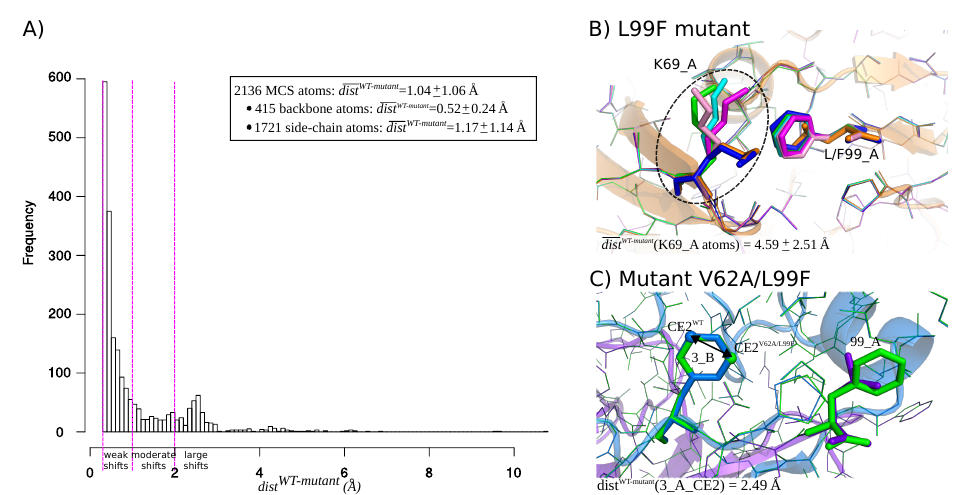
Figure 2. ( A ) Distribution of dist WT − mutant distances for MCS atoms extracted from the set of 155 mutant structures. Magenta lines corresponds to the cutoffs used to define a weak shift (0.3 Å < dist WT − mutant < 1 Å), moderate shifts (1 Å ≤ dist WT − mutant < 2 Å), and large shifts ( dist WT − mutant > 2 Å). ( B , C ) Illustration of atom shifts in the L99F ( A ) and V62A/L99F ( B ) mutants. ( B ) Superimposition of the five structures of the L99F mutant and the wild-type structure. Wild-type structure is colored in orange and represented in line and cartoon modes. The five structure of the mutant are represented in line mode and colored in magenta, cyan, blue, green, and pink. The L99F mutated residue is represented in stick mode. ( C ) Illustration of structural shift occuring at residue 3_B in the V62A/L99F mutant. The wild-type structure is represented in cartoon and line modes and colored according to its two chains: chain A is colored in purple and chain B is colored in marien blue. The mutant V62A/L99F structure is represented in lines and colored in green. The mutated residue 99_A and shifted residue 3_A are represented in stick mode. The arrow represents the dist WT − mutant of the CE atom of residue 3_B computed between the wild-type and the first structure of mutant V62A/L99F. CE 2 V 62 A / L 99 F and CE 2 WT correspond to atom CE of residue 3 of chain B in the V62A/L99F and wild-type structures and are represented in sphere